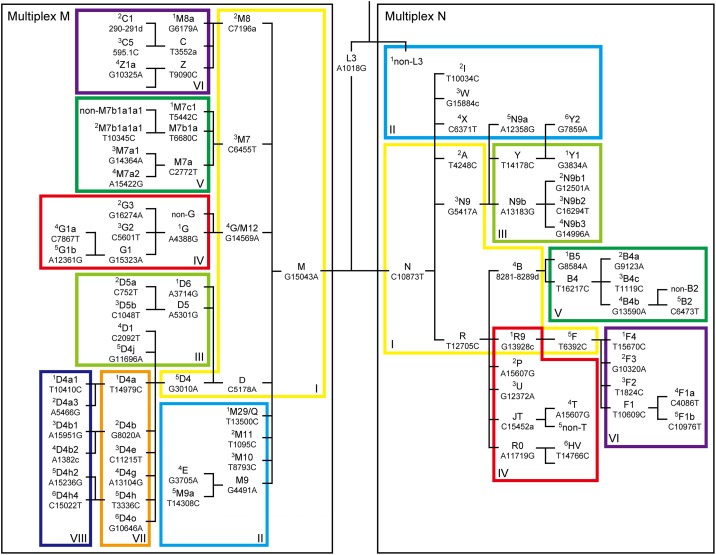
Scheme of mitochondrial DNA haplogroup assignment based on the haplogroup-defining mutations.The color coding of the frames is consistent with that employed to identify electrophoretograms in Figs 3 and 4. Superscript numbers correspond to the electrophoretogram lane numbers shown in Figs 3 and 4. The primer sets of multiplexes M-I to M-VIII and N-I to N-VI are shown in Tables 1 and 2, respectively.